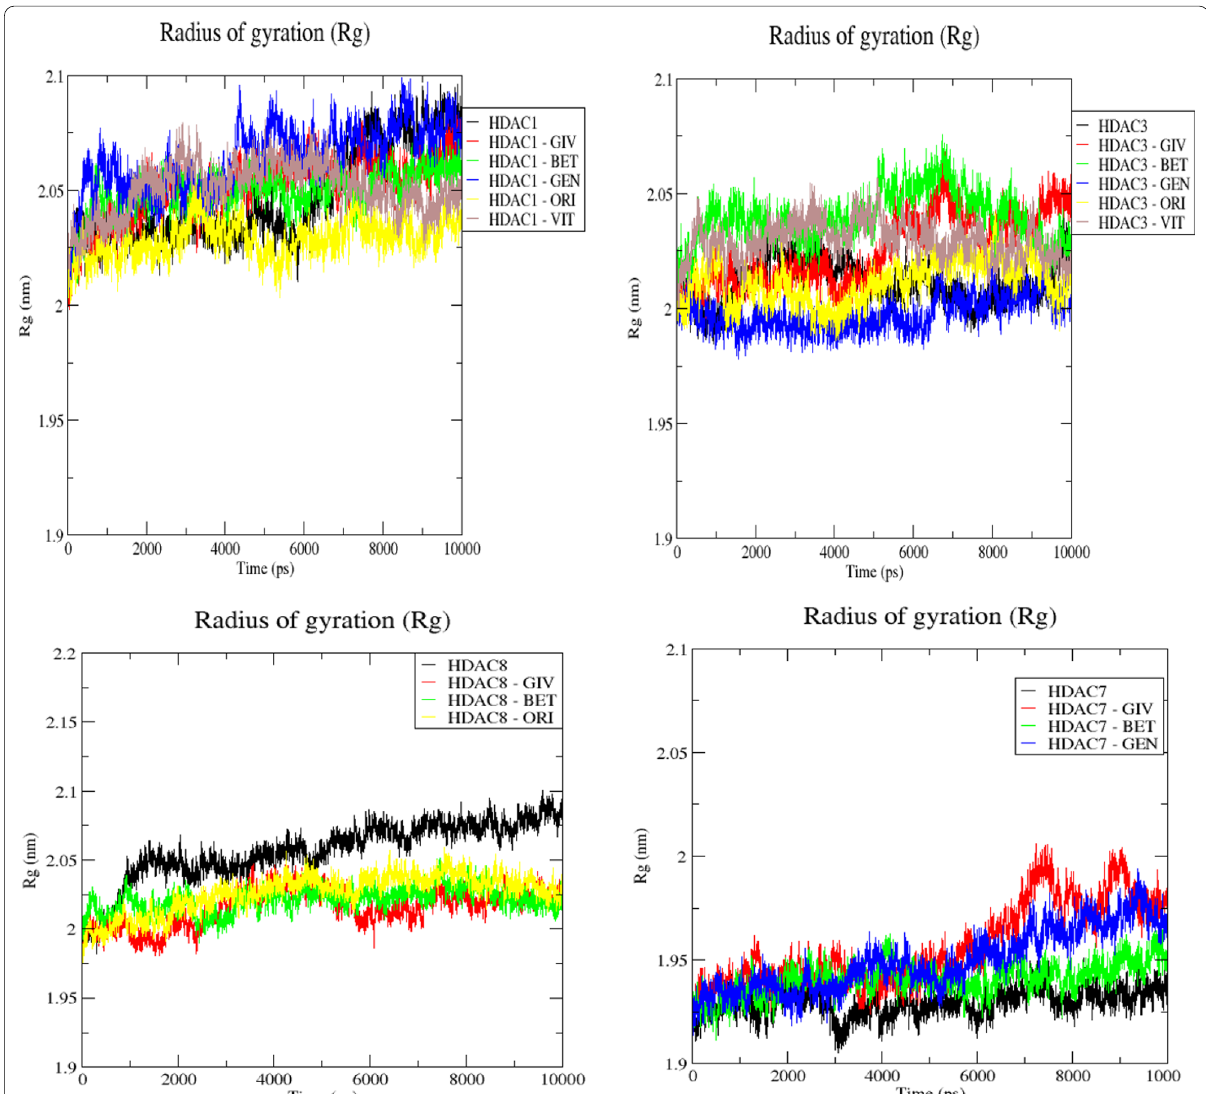
Fig. 11 Radius of gyration plots reflecting the changes observed in the conformational behavior of HDAC1, HDAC3, HDAC8 and HDAC7